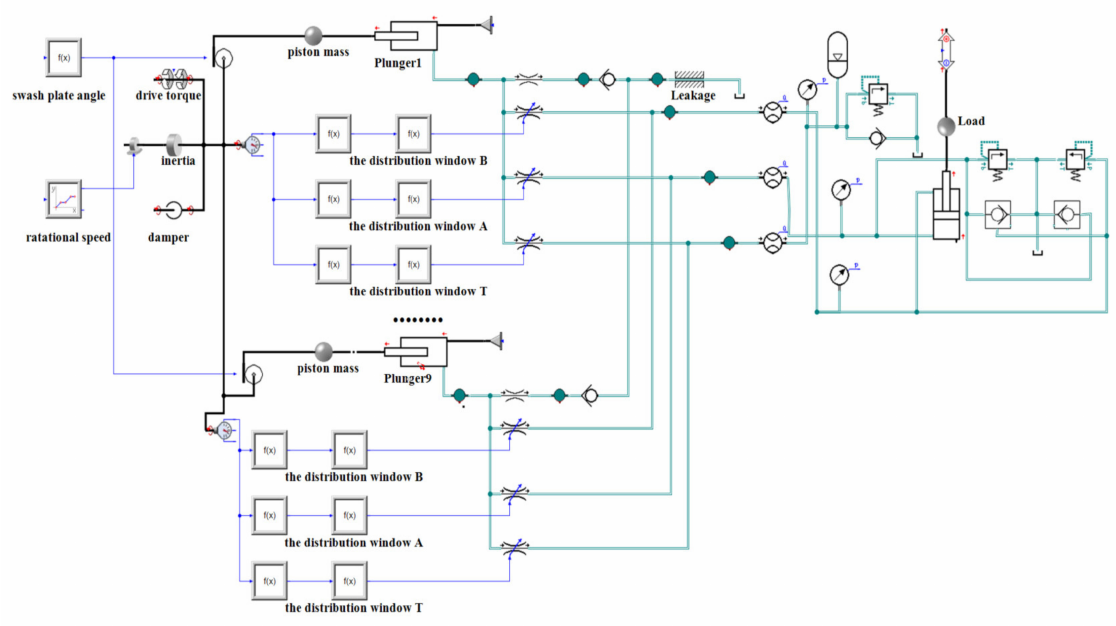
Figure 6. Simulation model of the proposed